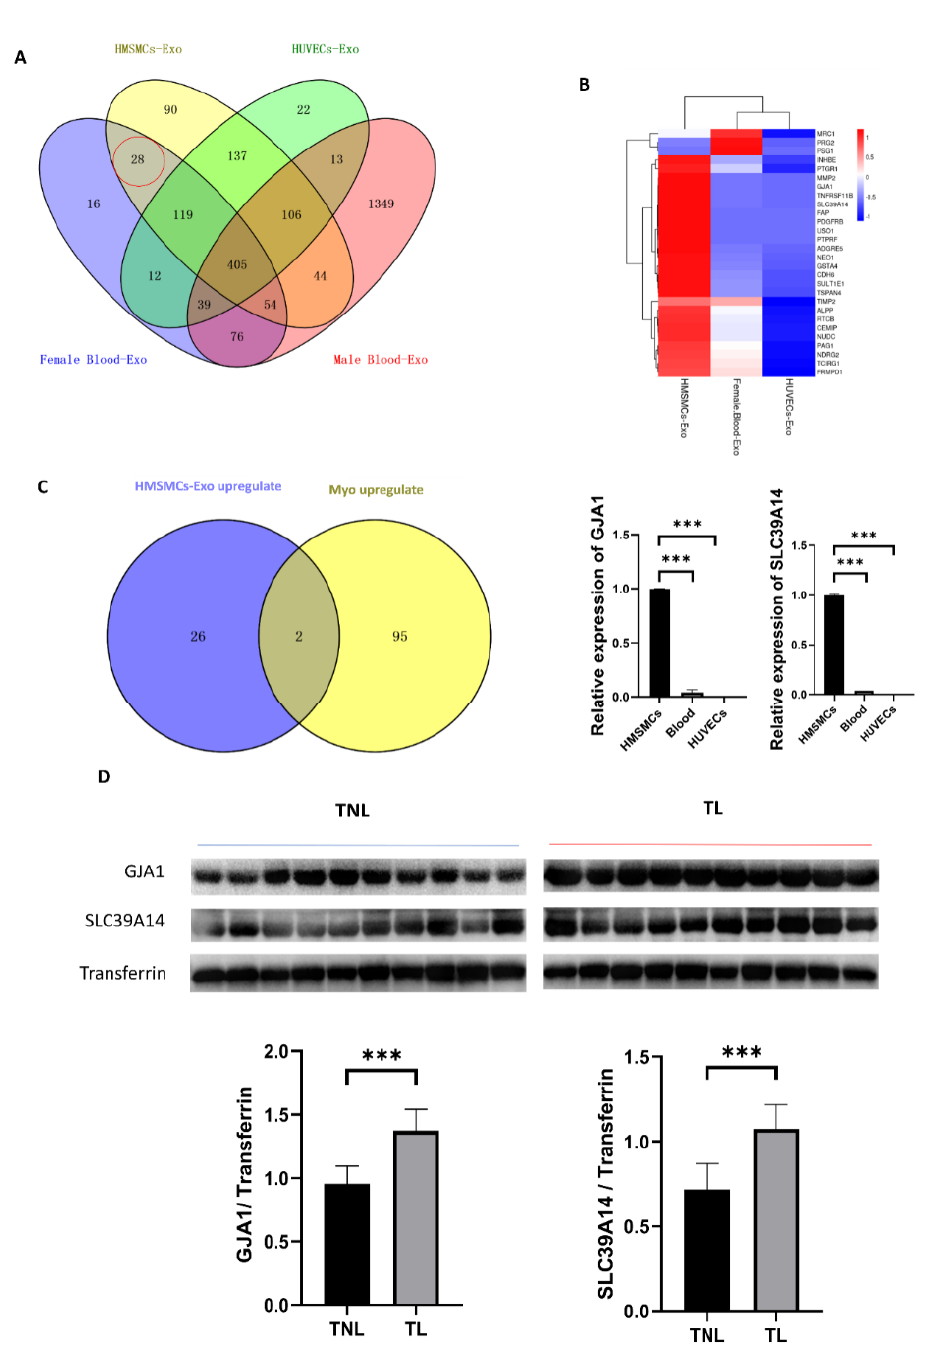
Figure 4. Myometrial contraction-specific biomarkers among exosomal proteins. ( A ) Venn diagram of miRNAs identified in HMSMC, HUVEC, and female blood- and male blood-Exo. ( B ) Heatmaps of the expression of the proteins identified in HMSMC, HUVEC, and female blood-Exo. ( C ) Venn diagram of proteins upregulated in HMSMCs-Exo and laboring myometrium, and GJA1 as well as SLC39A14 are the only two overlapping proteins and confirmed using qPCR. ( D ) GJA1 and SLC39A14 were upregulated in the peripheral blood of TL women; n = 10. *** p < 0.001.